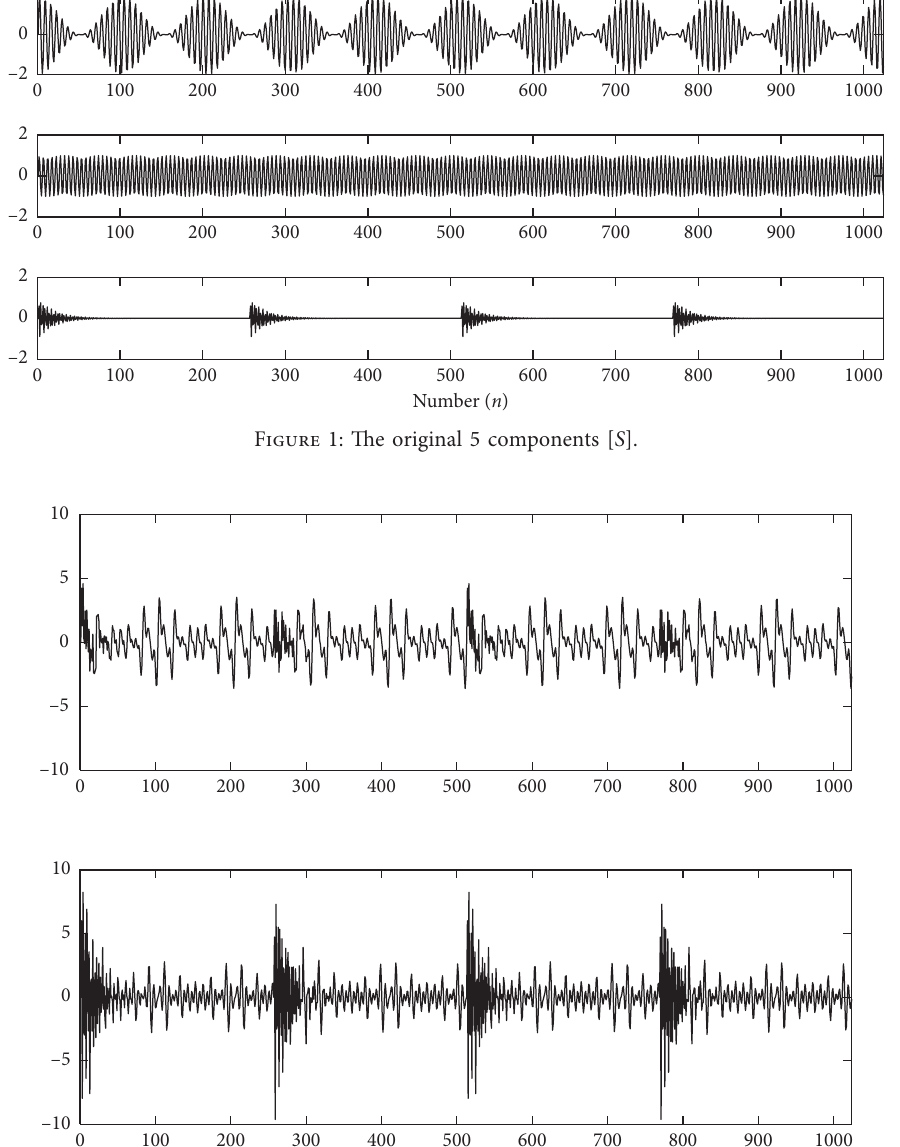
Figure 2: The 2 observed signals [ X